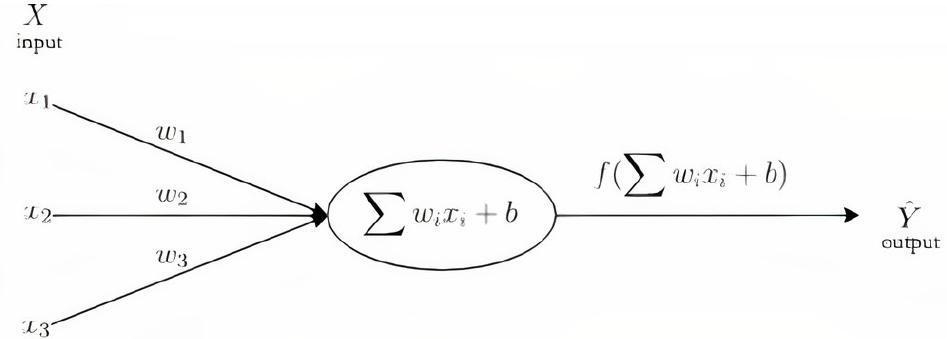
Figure 1. Representation of the non parametric modelling used in this